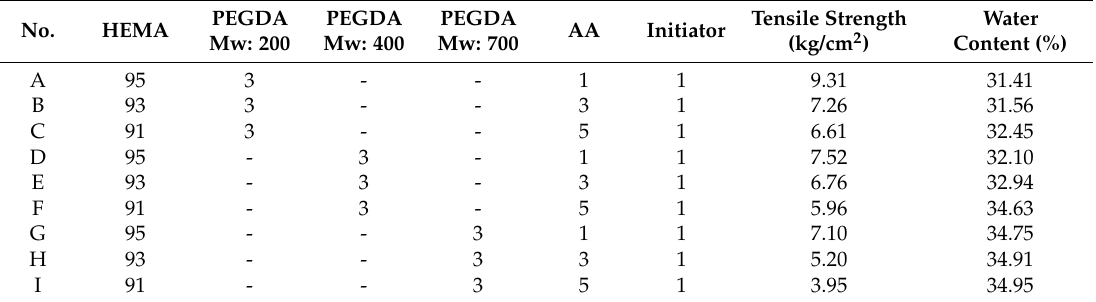
Table 1. The tensile strength and water contents of different types of